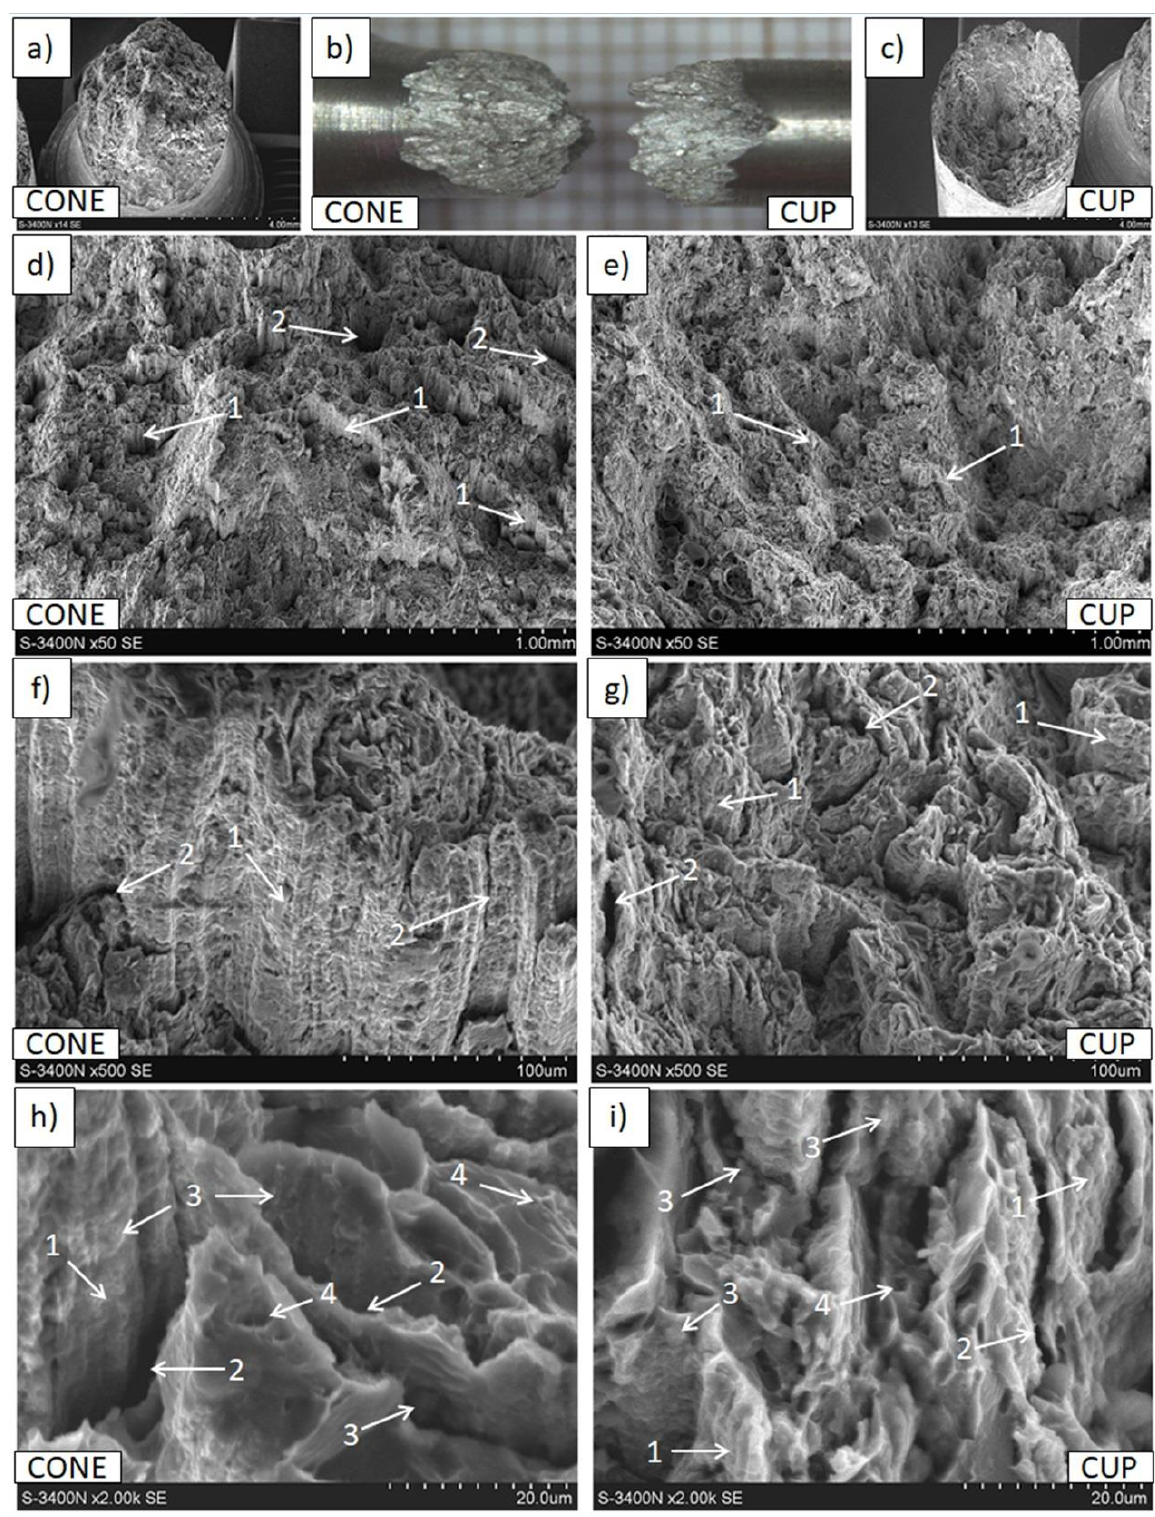
Figure 12. Decohesion effects in Mg(S) rod after tensile strength test. View of sample, fracture of cone and cup type ( a – c ). SEM micrographs of fracture surface ( d – i ) with plastic deformed and curved metal bands (1), cracks (2), fine oxides (3), and dimples of plastically deformed α -Mg (4).